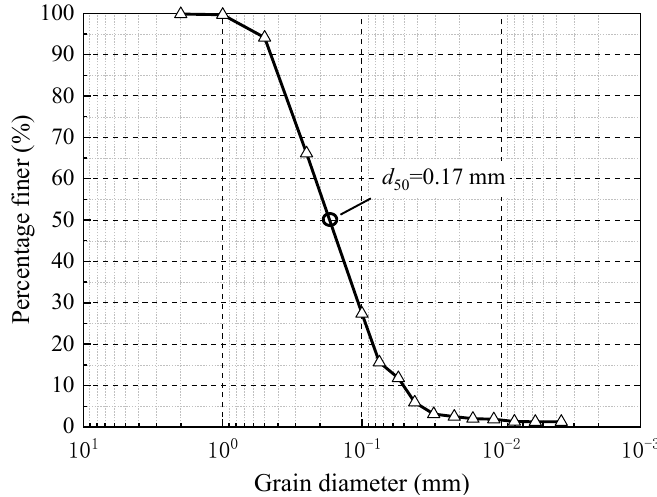
Figure 4. Gradation curve of sand particles.